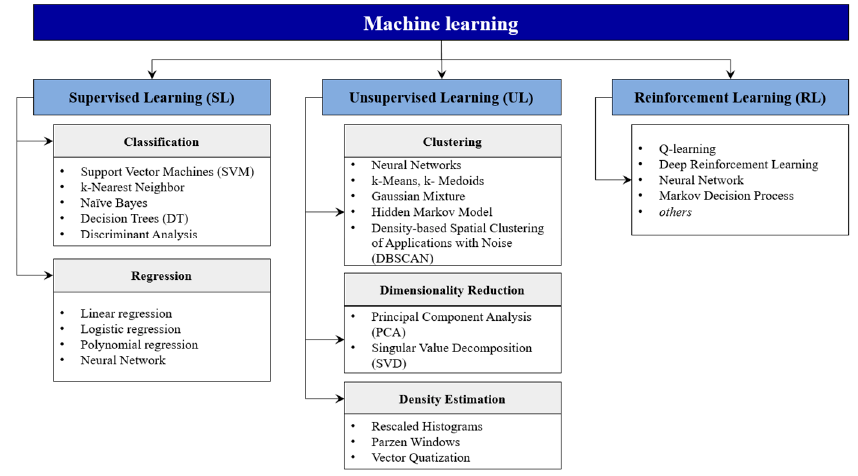
Figure 1. The classification of ML algorithms (based on [6,10]).